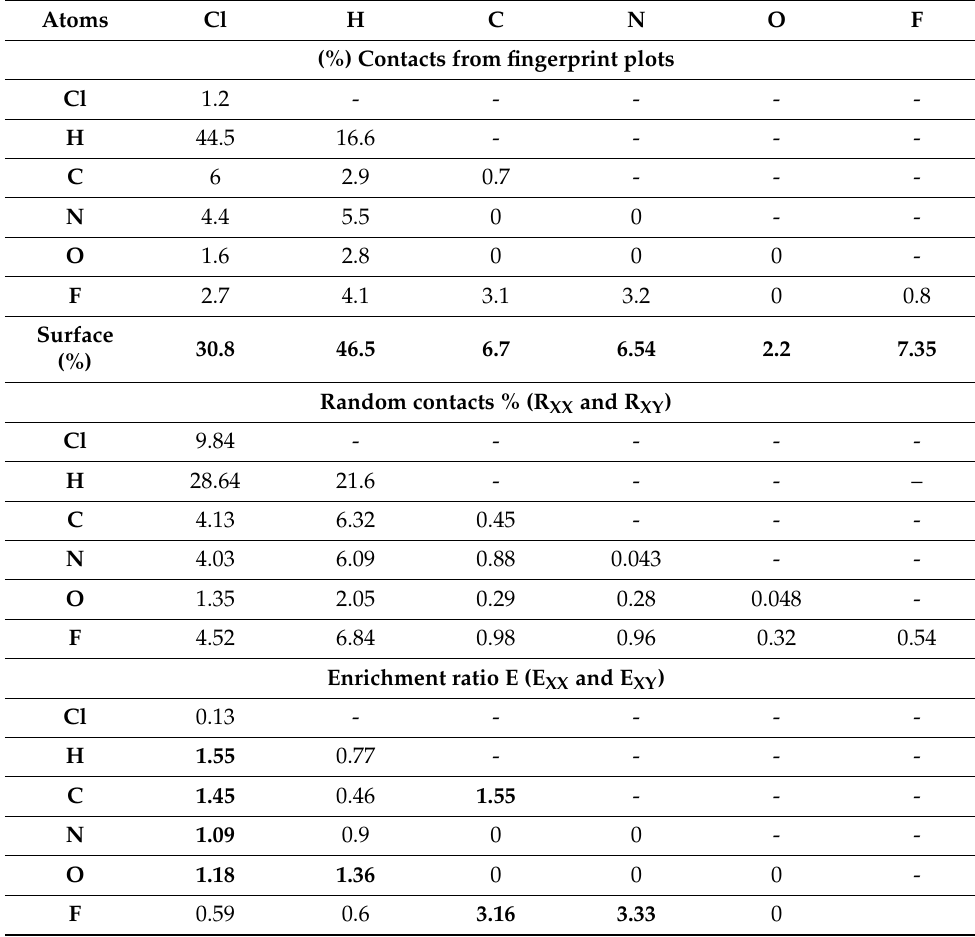
Table 3. Analysis of contacts on the Hirshfeld surface. The % of contact types (SX) between chemical species is given followed by random contacts (%) and their enrichment ratio (E). The major contacts as well as the major enriched ones are highlighted in bold